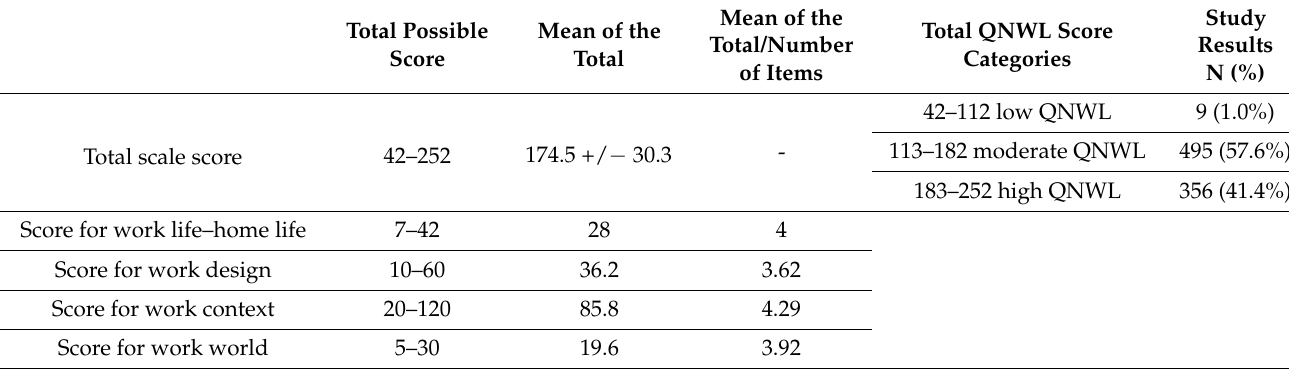
Table 2. Quality of work life among nurses based on dimensions.